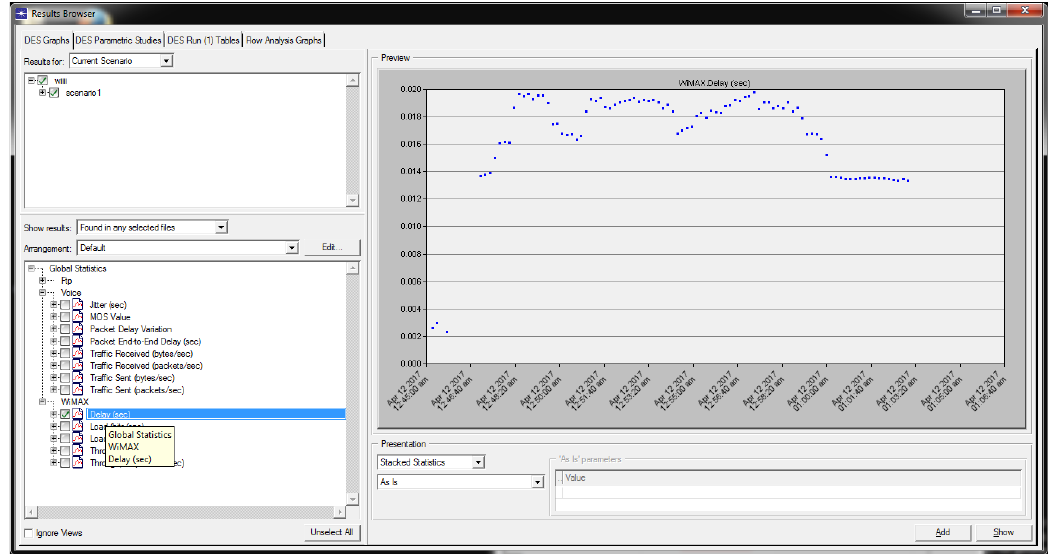
Fig. 6. Global Statistics WiMax delay second for overall network.